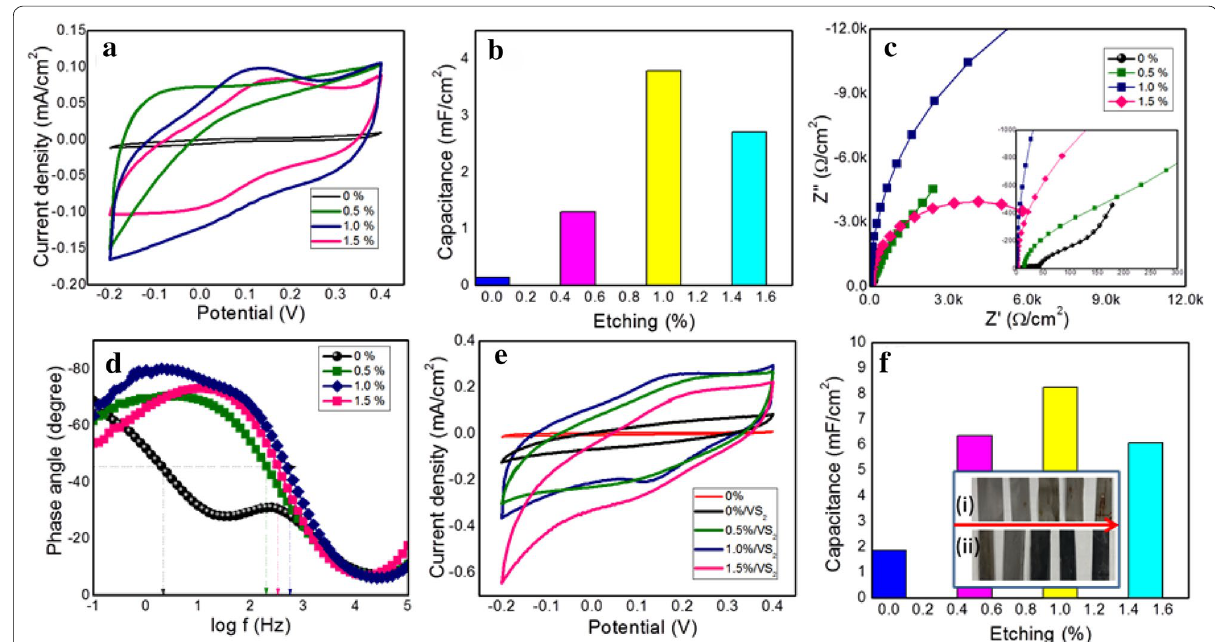
Fig. 5 The electrochemical characterizations of the surface‑modified SSM samples; a cyclic voltammograms of the SMSSM substrate at different etching concentrations, b the graph of areal capacitance as a function of etching concentration. Electrochemical impedance results in the 0.1 Hz to 100 KHz frequency range; c Nyquist plot for all prepared samples. Inset shows the enlarged view of the Nyquist plot and d Bode phase angle plots for etched SMSSM substrates. e Cyclic voltammogram at a scan rate of 20 mV/s scan rate for the VS 2 nanomaterial deposited on etched SMSSM